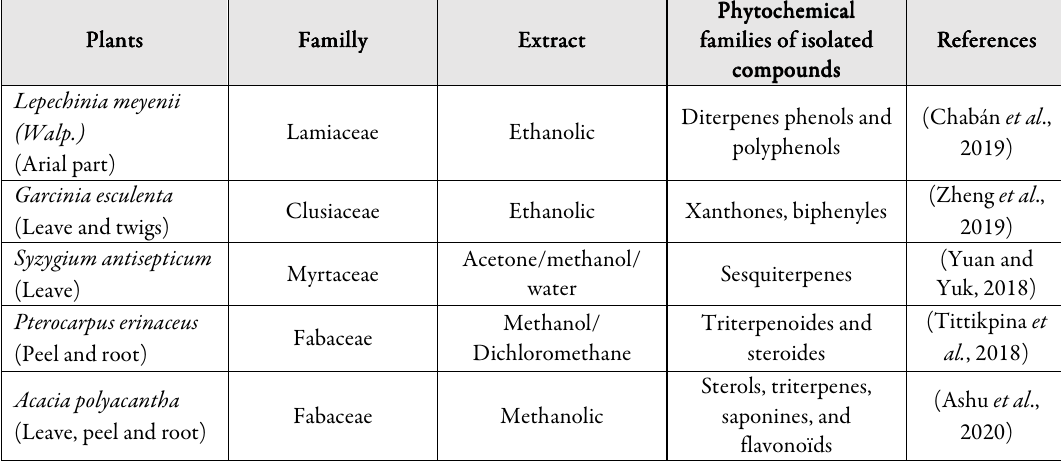
Table 1. Some effective crude extract fractionated against S. aureus